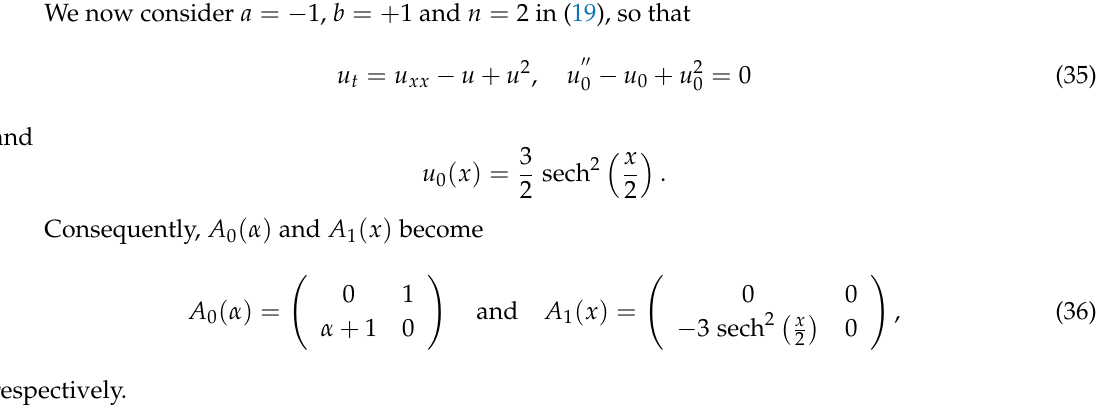
Figure 1. Numerical evaluation of the Evans function E ( α ) for the Equation